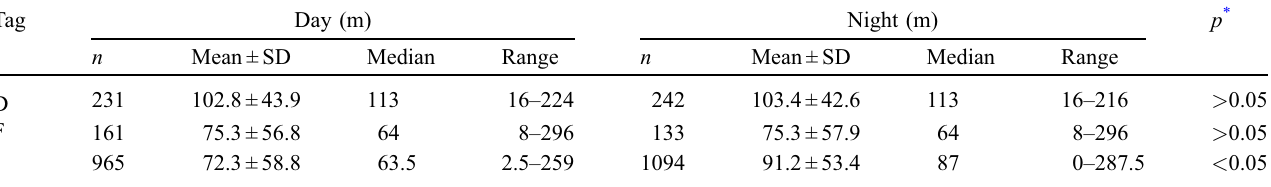
Table 2. Comparison of the mean depth of the vertical movements of 3 yellow fi n tuna in the daytime and nighttime. Tag